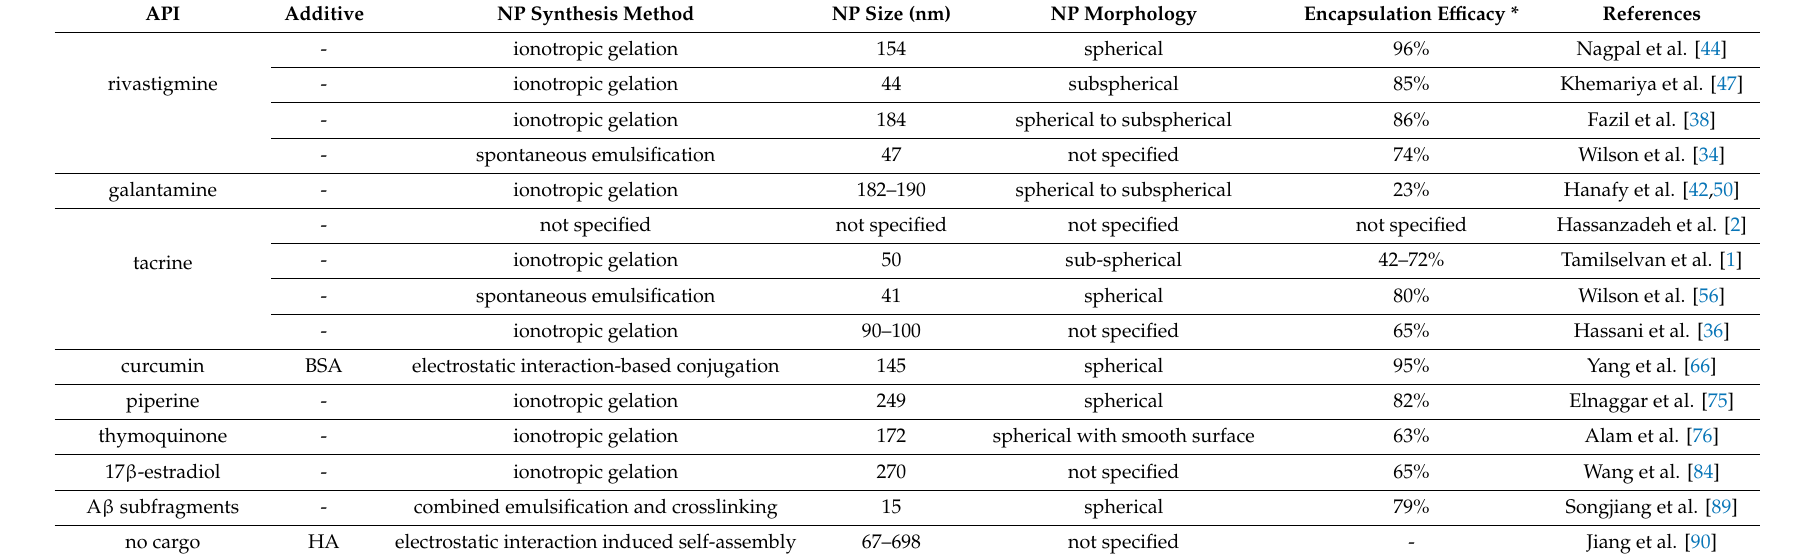
Table 1. Overview of chitosan-based nanoparticles developed for the treatment of Alzheimer’s